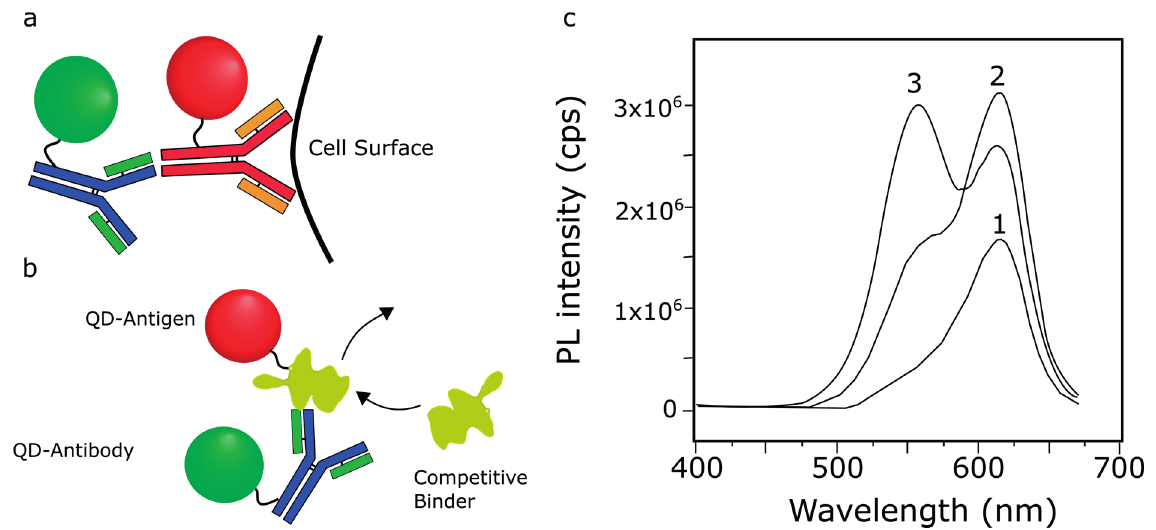
Figure 12. ( a ) Schematic for sensing primary-secondary antibody interaction. Binding of the QD-labeled secondary antibody to the QD-labeled primary antibody brings the donor and acceptor QDs into close proximity, inducing FRET; ( b ) Schematic of competative antibody-antigen binding assay. The QD-labeled antibody binds to a QD-labeled antigen, bringing the donor and acceptor QDs into close enough proximity for efficient energy transfer. In the presence of additional antigen (e.g., an unlabeled endogenous molecule), the QD-labeled antigen is displaced, reducing energy transfer and yielding a measurable change in the PL of the system. Using an unlabeled antigen as the competitive binder reveals the antigen-antibody binding affinity. Schematics are not drawn to scale; ( c ) PL spectra demonstrating that competitive binding can reverse FRET signal. ( c1 ) PL spectrum of QD-antibody (acceptors only); ( c2 ) PL spectrum of QD-antigen bound to QD-antibodies, showing increased acceptor intensity due to FRET; ( c3 ) PL spectrum of the QD-antigen + QD-antibody complex in the presence of the competitive binder, showing an increase in the donor peak intensity and decrease in the acceptor peak intensity; ( c ) Reprinted with permission from [88]. Copyright (2002) American Chemical